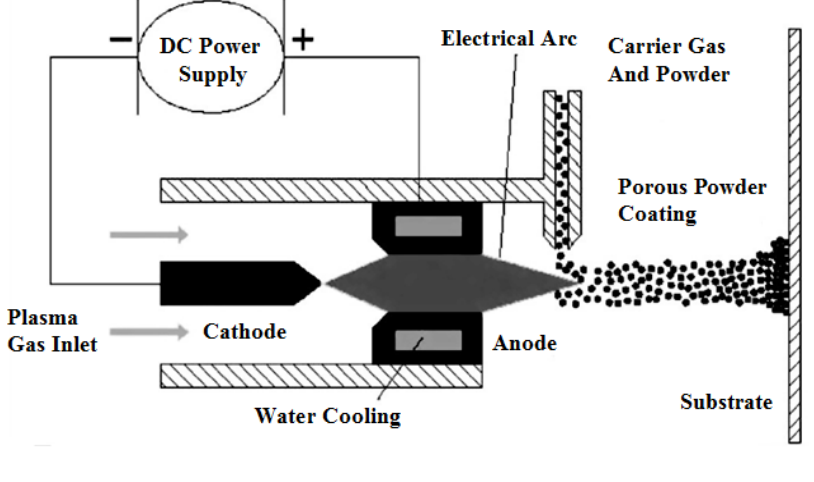
Figure 32. Schematic representation of the plasma spraying process [232]. Reprinted with permission from [232]. Copyright 2006